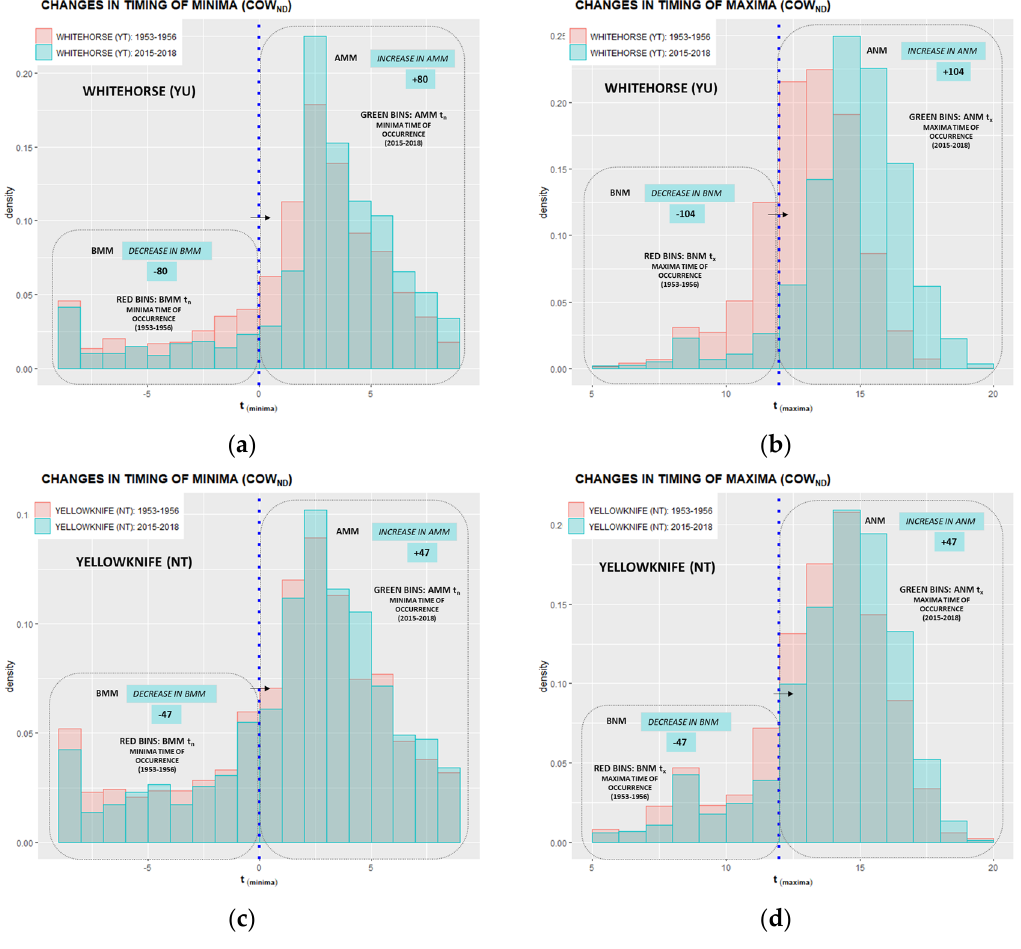
Figure A21. Northern Canada climate region: Whitehorse (YU) and Yellowknife (NT). Time evolution of the Diurnal Extrema Timing (DET) histograms at Whitehorse ( a , b ), and Yellowknife ( c , d ) stations. Migration of the Before Midnight Minima (BMM) to After Midnight Minima (AMM) and migration of the Before Noon Maxima (BNM) to After Noon Maxima (ANM) between four-year averages at the beginning (1953–1956) and ending (2015–2018) of data ranges. The blue dotted line represents midnight delineation ( left ) and noon delineation ( right ).